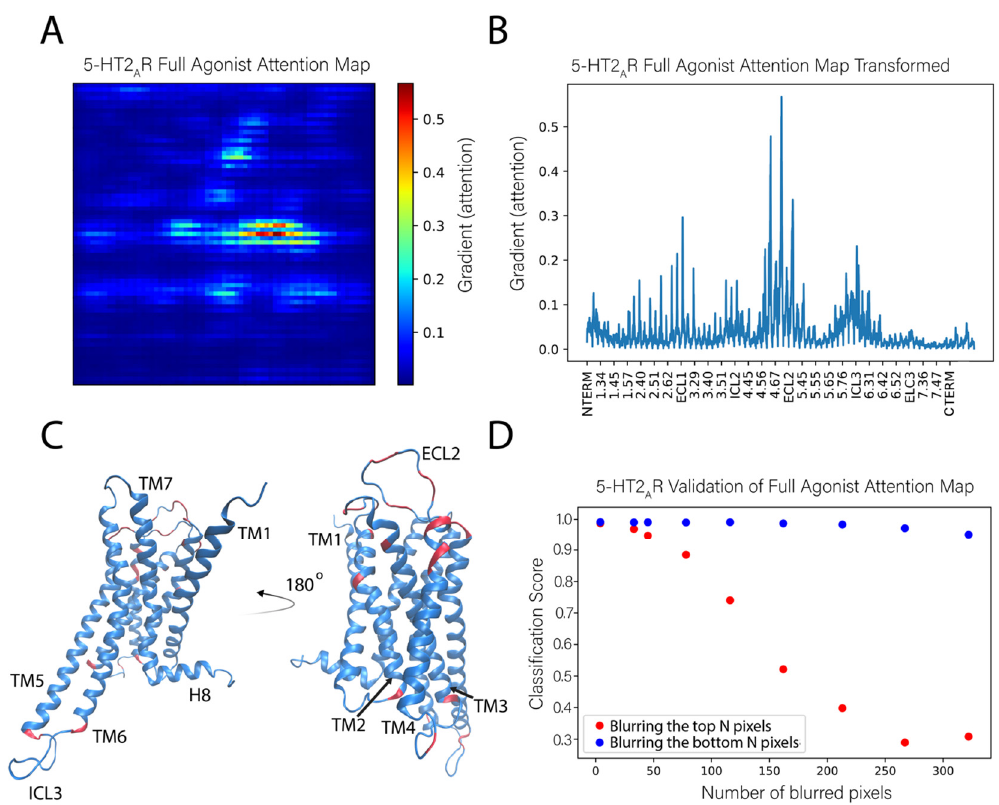
Figure 6. Identification of the molecular determinants of the classification of the full agonist bound to the 5-HT 2A R. ( A ) The full agonist attention map shown was obtained as the average of 1000 attention maps calculated from 1000 instances of the full agonist bound to the 5-HT 2A R. ( B ) Representation of the (average) attention map in panel A in which all the pixels (i.e., atoms) are listed on the X axis. The tick marks on the X axis identify residues labeled with the generic Ballesteros–Weinstein numbering [20]. The gradient values calculated for the classifier for individual atoms is on the Y axis, it indicates the order of importance (salience) of each atom for the classification. ( C ) The positions of the most important residues for the classification are indicated (in orange) on the ribbon representation (in blue) of the 5-HT 2A R model structure. The highlighted residues contain atoms whose gradient (attention) is > 0.15. ( D ) Validation of the attention map by evaluation of the e ff ect of blurring increasing numbers of pixels (atoms) in the representation of the protein complex. Orange dots indicate the results of blurring increasing numbers of pixels identified to have the lowest gradient (least important). Blue dots indicate the results of blurring pixels with the highest gradient (most important). The number of atoms blurred is shown on the X axis while the Y axis shows the corresponding classification score of the full agonist for the blurred